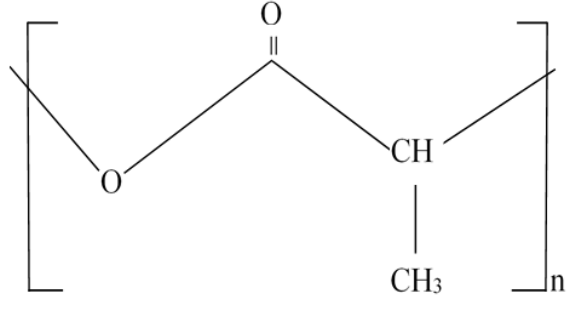
Figure 1. Polylactide (PLA) structure.